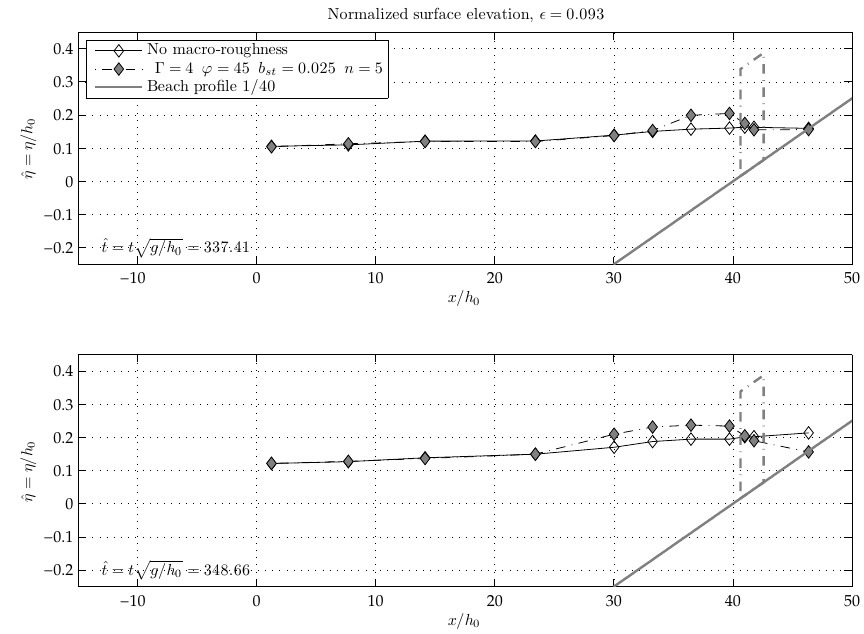
Fig. 15. Comparison of the normalized surface elevation for a sinusoidal wave with (cid:15) = 0 . 093 at ˆ t = 337 . 41 and ˆ t = 348 . 66 with and without the presence of macro-roughness elements. The macro-roughness element configuration is specified by 0 = 4, ϕ = 45 ◦ , b st = 0 . 025 and n = 5. Surface elevation and spatial coordinates are normalized by the invariant water depth ( h 0 ). The dash-dotted line depicts the macro- roughness element area.